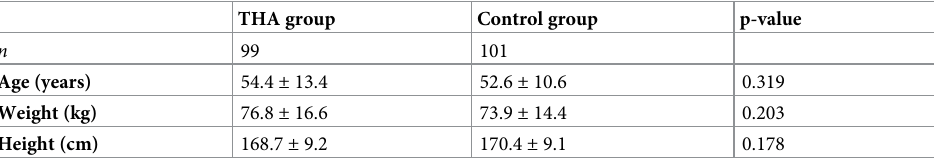
Table 1. Epidemiological characteristics of the study group (left column) and control group (right